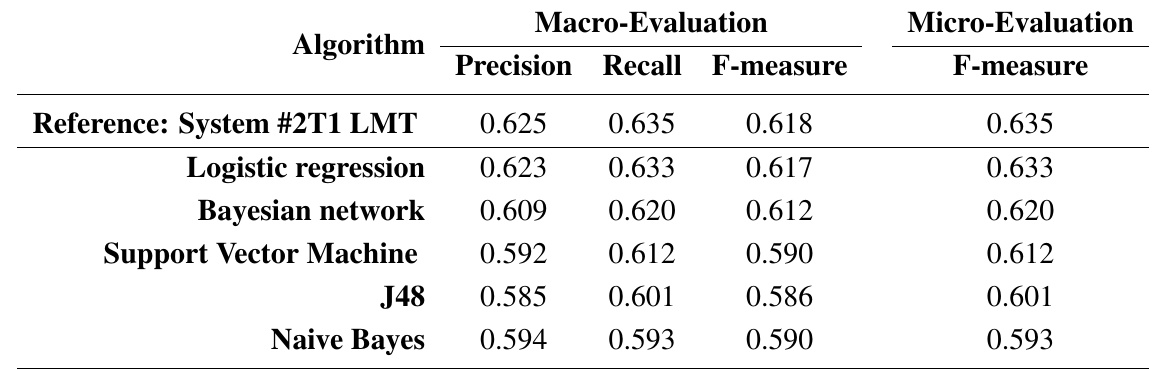
Table 3. Micro- and macro-evaluations of six classifiers on the training corpus for the difficulty classification